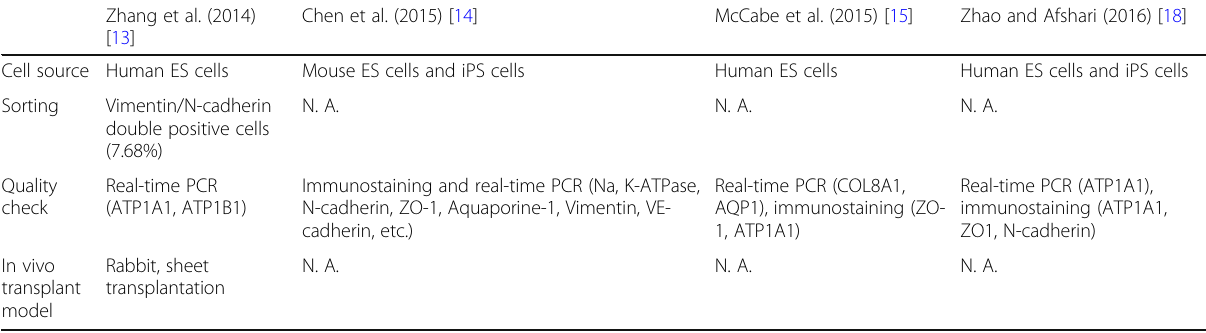
Table 5 Summary of details of reviewed methods, including cell source and strain (ES or iPS cells, mouse or human), markers for cell sorting, quality check experiments, and in vivo transplant methods